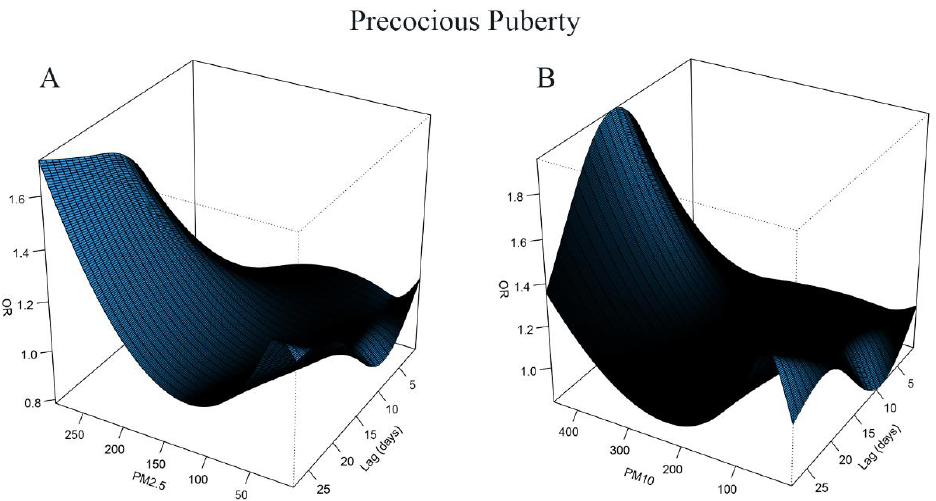
Figure 2. The three-dimensional (3D) plots of lag associations up to 28 days of PM 2.5 ( A ) and PM 10 ( B ) exposure with odds ratios (OR) of precocious puberty.